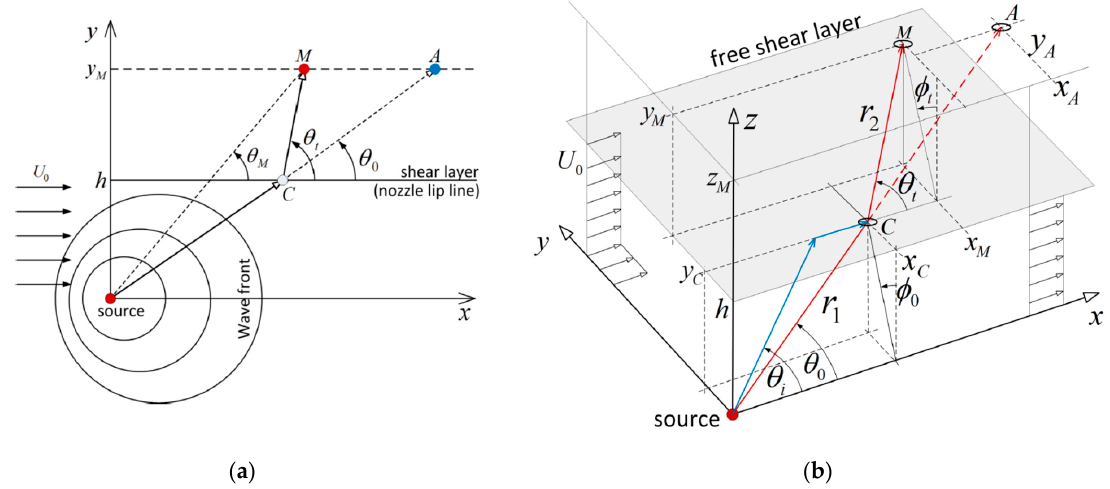
Figure 11. Geometrical parameters for the shear layer correction: ( a ) 2D case, ( b ) 3D case (adopted from [24]).